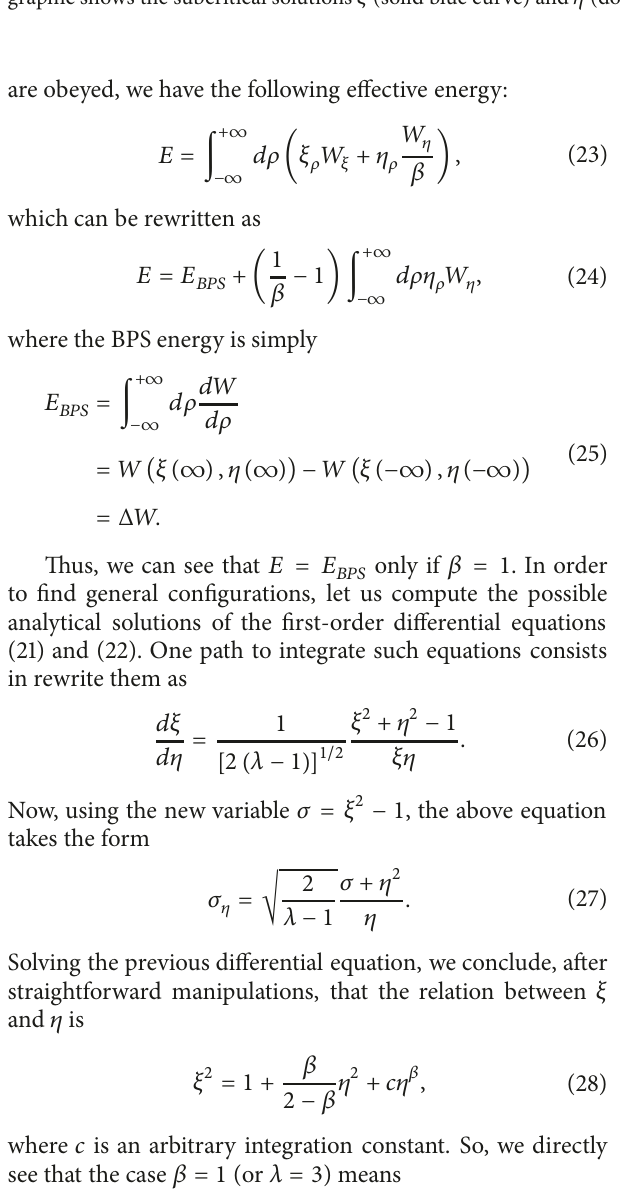
Figure 1: In the left panel we present the critical solutions 𝜉 (solid blue curve) and 𝜂 (dotted red curve) for 𝛽 = 1 and 𝑐 = −2 . The right graphic shows the subcritical solutions 𝜉 (solid blue curve) and 𝜂 (dotted red curve) for 𝛽 = 1 and 𝑐 = −3 .